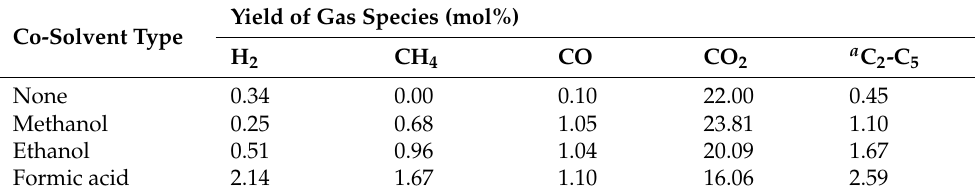
Table 4. Concentration of gaseous species (relative to N 2 ) in co-solvent assisted HTL of S. platensis (at 300 ◦ C, 30 min time, 20% solids concentration, solvent/water ratio 1:10, and 2 MPa initial N 2